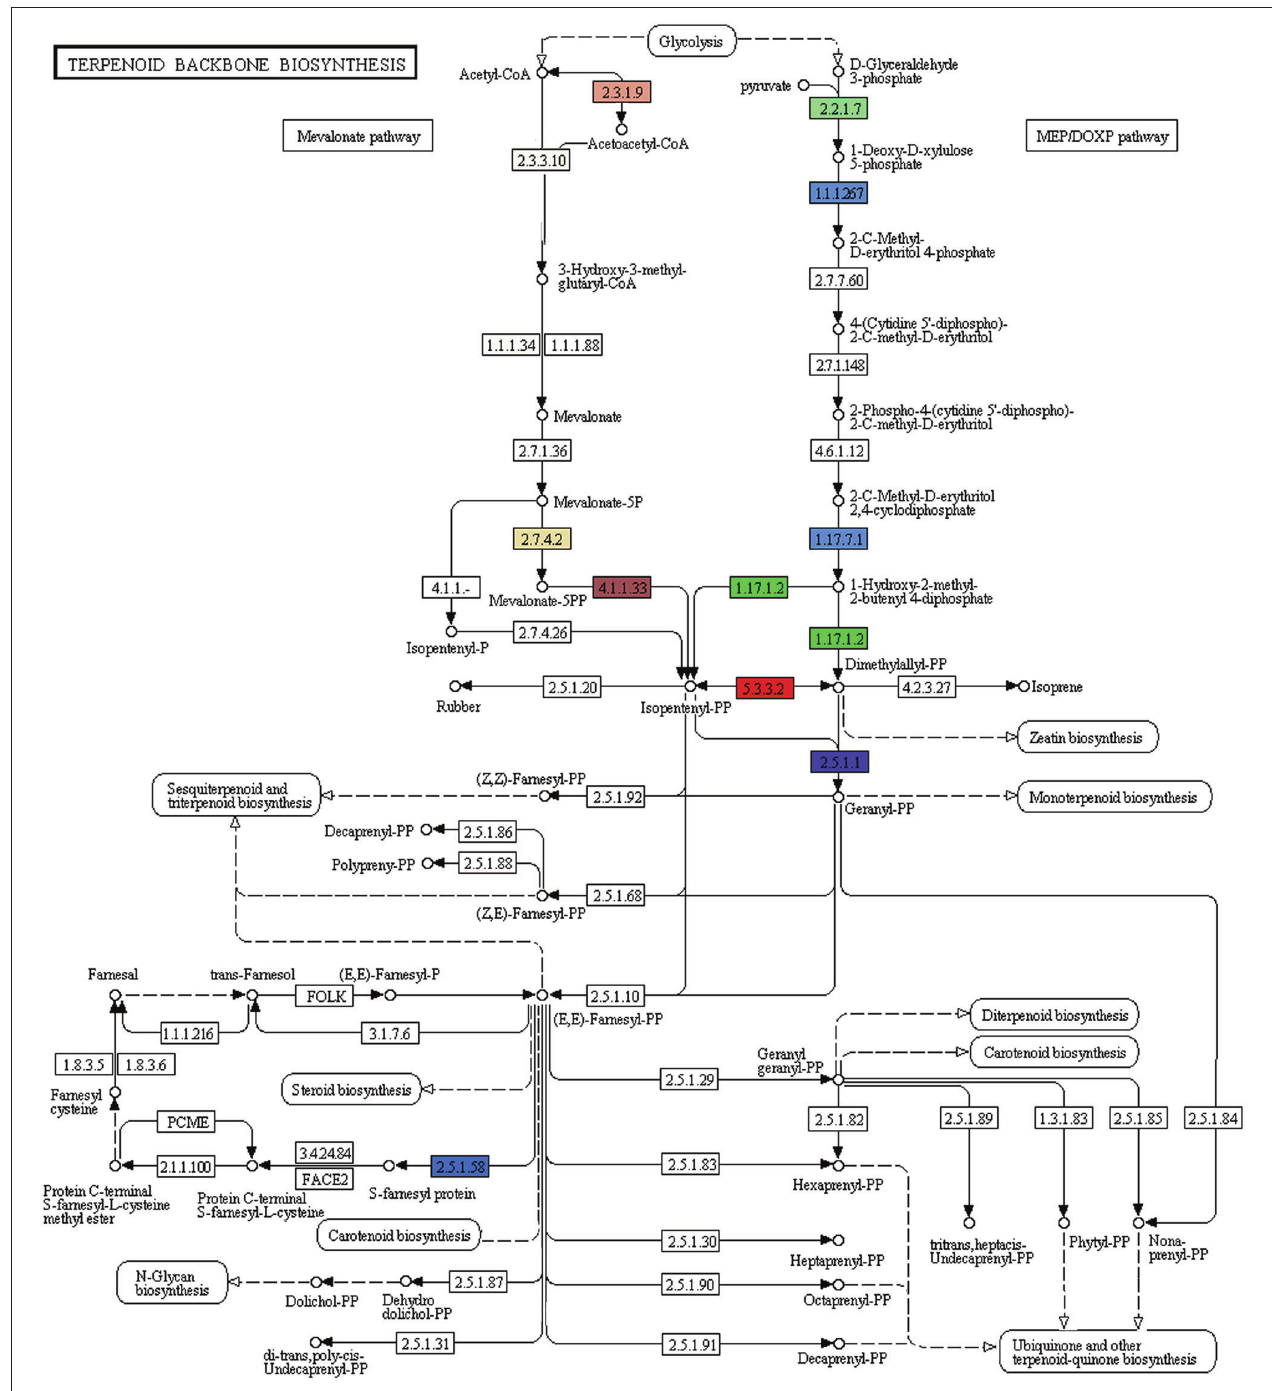
FIGURE 8 | KEGG analysis showing genes involved in MVA, MEP pathways forming the terpenoid backbone biosynthesis (Each EC with one color).